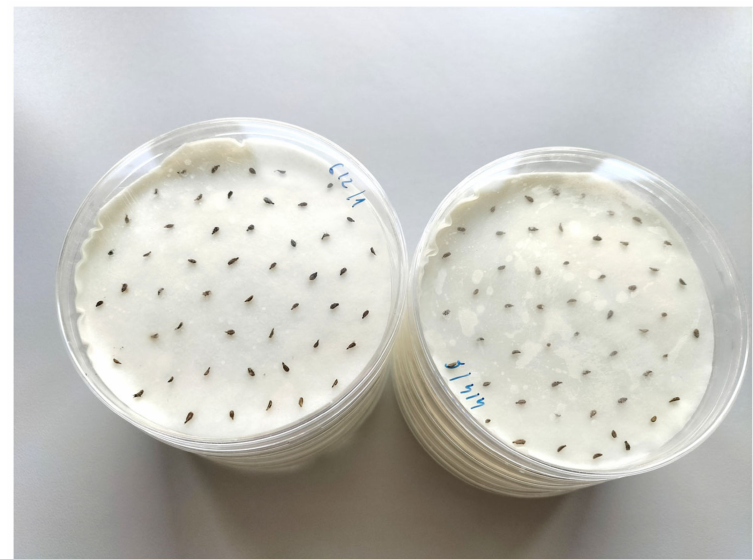
Figure 1. Seeds of both samples prepared for the germination test.